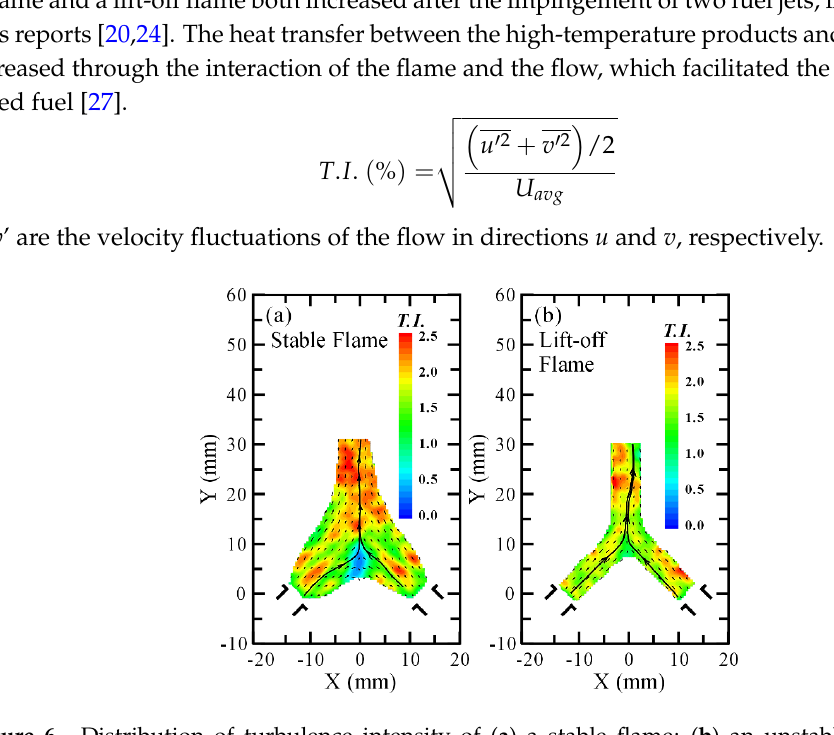
Figure 6. Distribution of turbulence intensity of ( a ) a stable flame; ( b ) an unstable flame of a CH 4 /syngas/air premixed impinging flame.